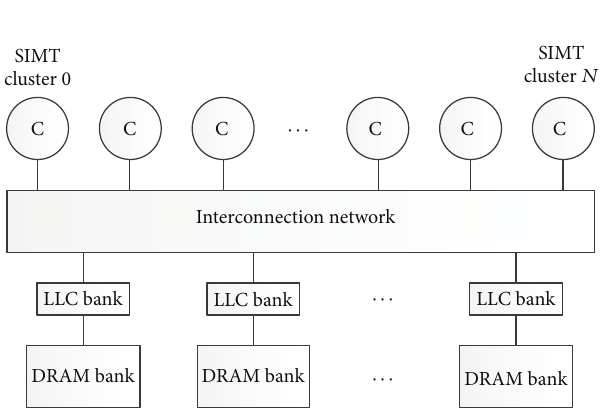
Figure 1: Baseline GPU